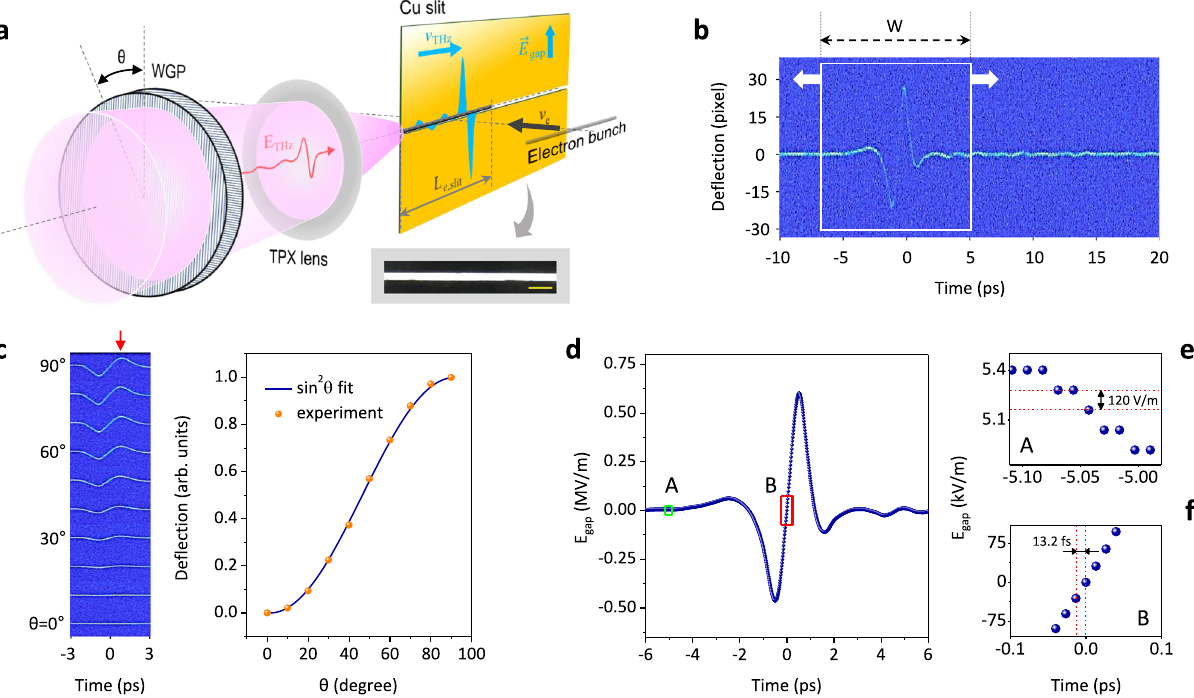
Fig. 2 Proof-of-concept experiments for THz optical waveform measurement. a Simple layout of the experimental setup. As the incident optical signal